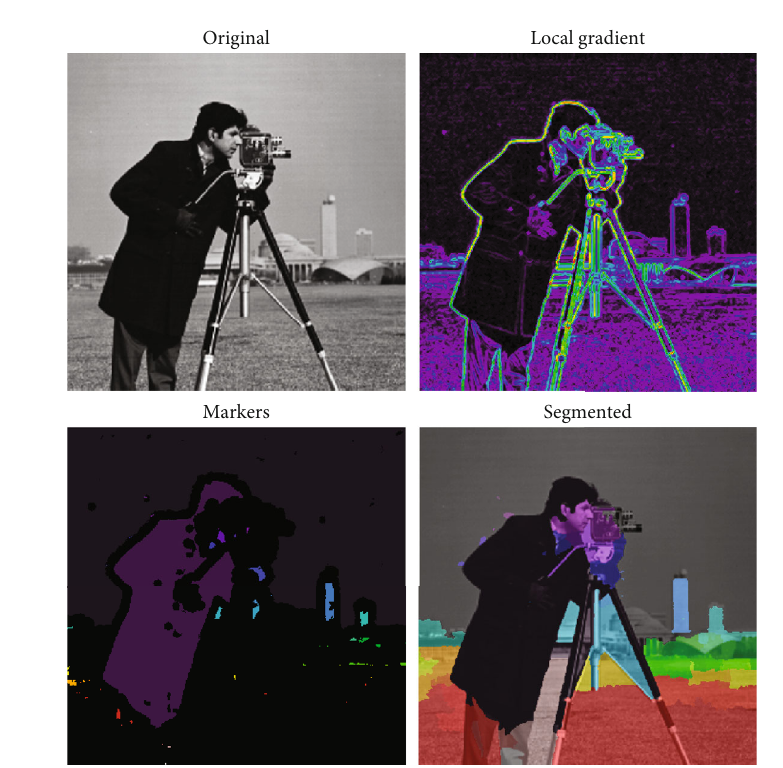
Figure 4: Segmentation processing e ff ect of this